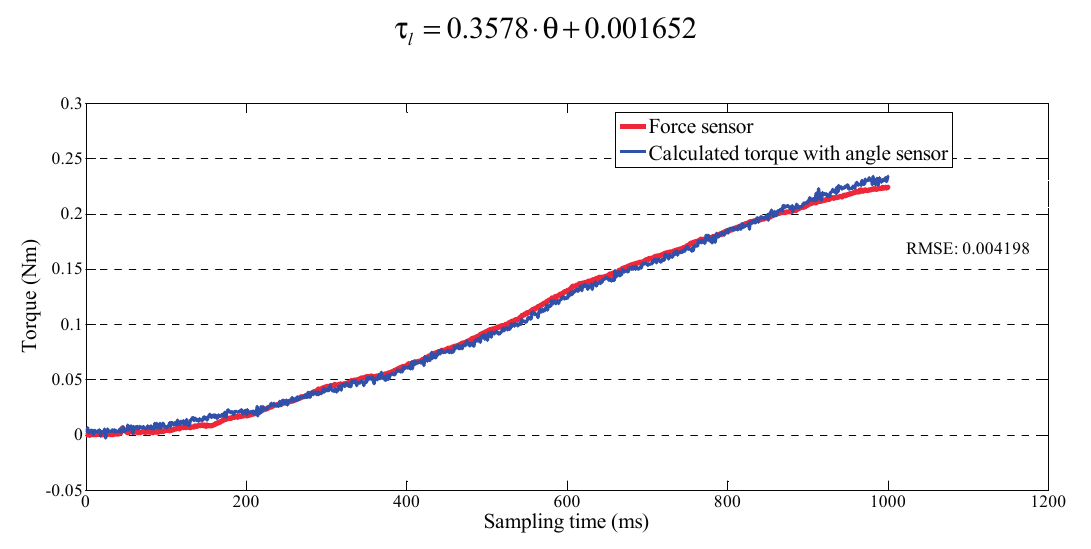
Figure 8. Calibration results for the force-sensing